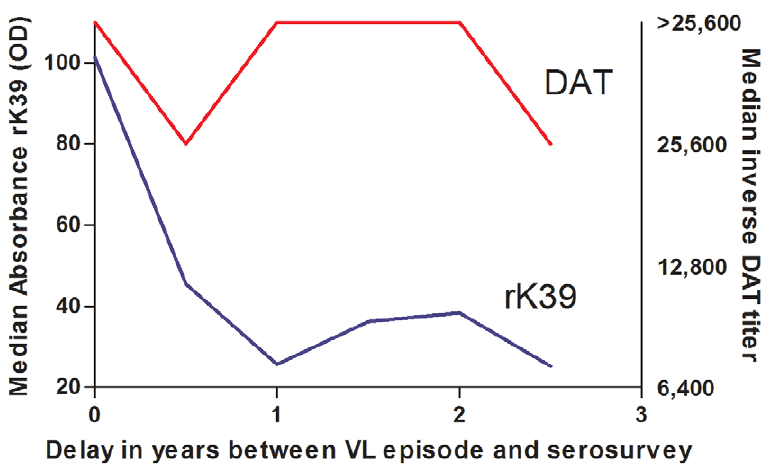
Figure 4. Median DAT and rK39 titers among 6-months cohorts of former VL patients in function of the time that elapsed since diagnosis (n=118).